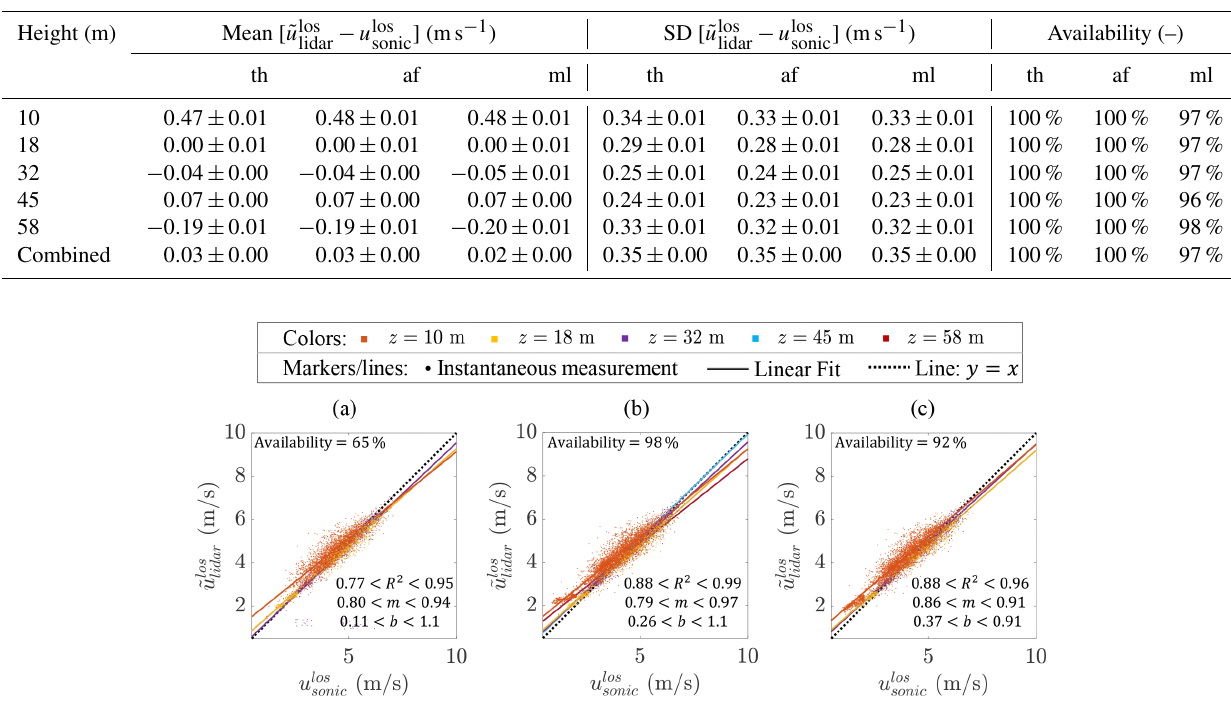
, versus sonic anemometer line-of-sight velocity esti- lidar